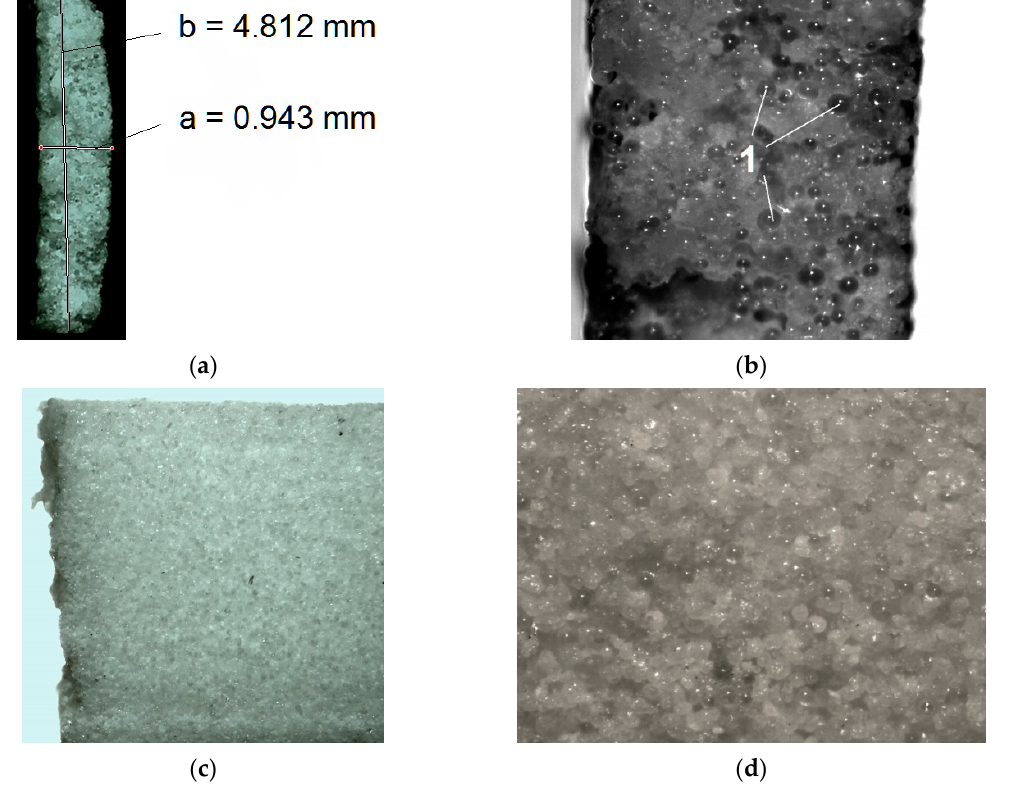
Figure 5. Photographs of the sample surface taken with a stereoscopic microscope; ( a ) cross-section of the broken sample with dimensions—6× magnification, ( b ) cross-section of the torn sample with visible glass powder grains (1)—50× magnification, ( c ) flat surface of the sample with the visible tear point—12× magnification, ( d ) flat surface of the sample—50× magnification.